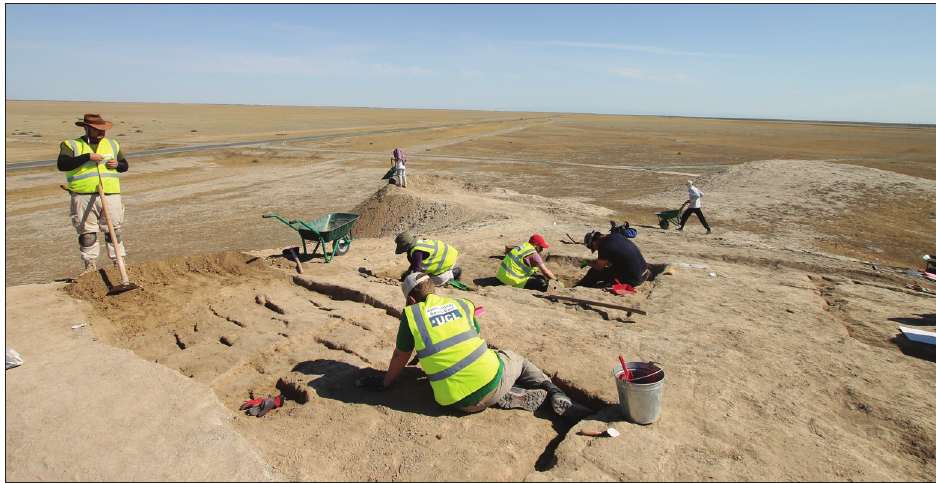
Figure 2: Excavating the 7 th /8 th century corner tower of the Kuik-Mardan citadel, Otrar, Kazakhstan. Photo: CAA: Archaeology